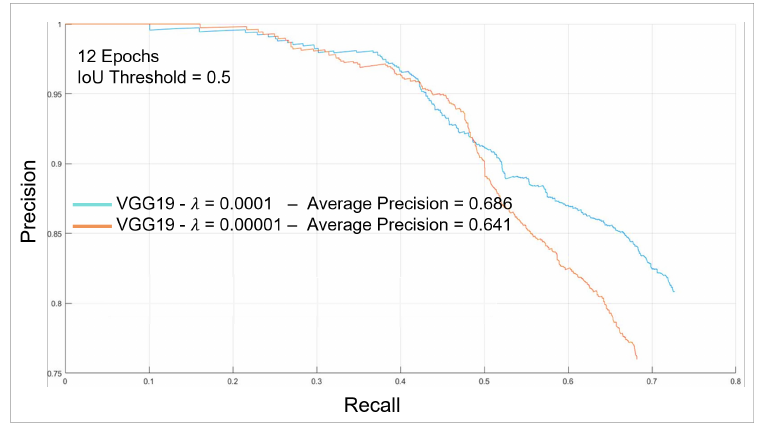
Figure 25. Recall–precision curve for VGG19 networks trained for 12 epochs. IoU threshold = 0.5.